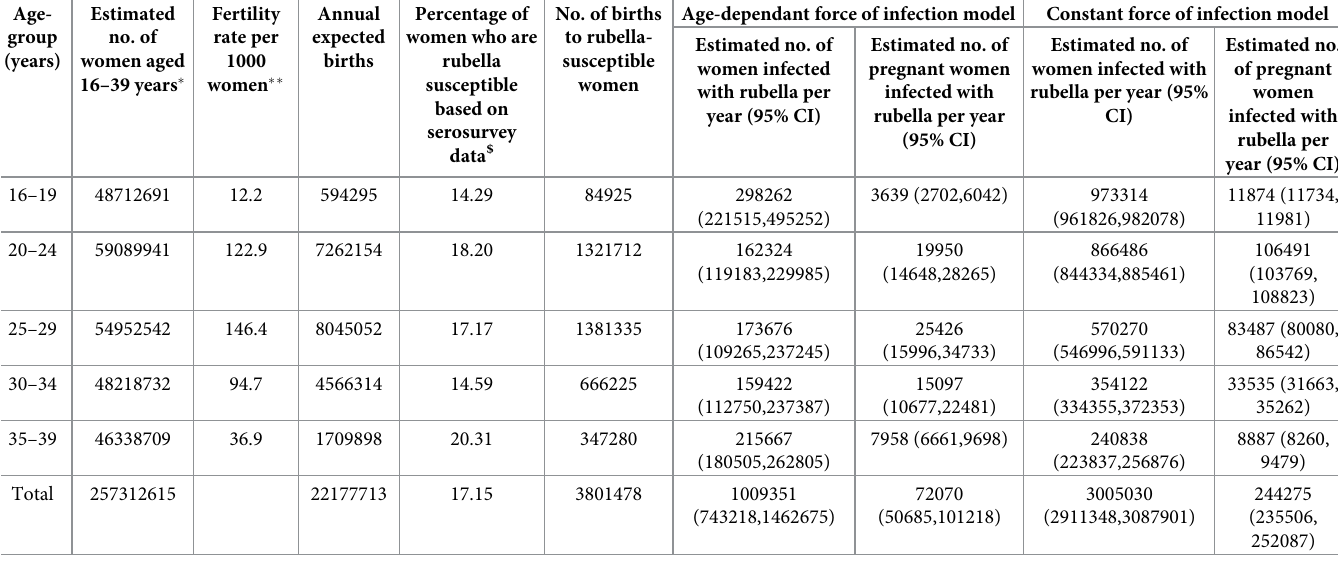
Table 3. Estimated number of pregnant women aged 16–39 years infected with rubella infection in a year in India. Age- Estimated group no.